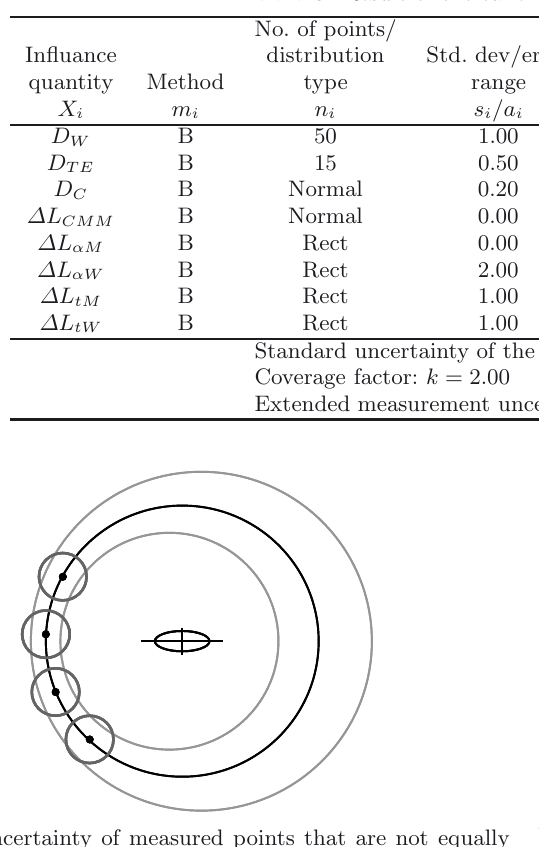
Table 3. Result of the calibration of the radius feature.